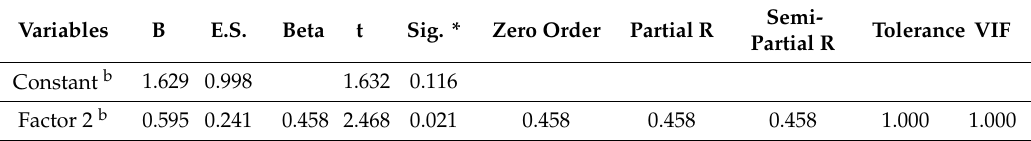
Table 10. Linear regression of the development of mathematical thinking a,c in early childhood education for men.